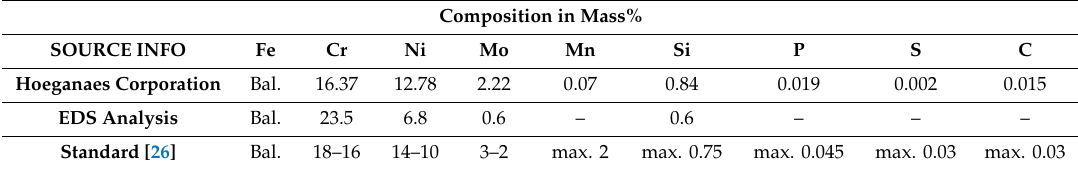
Table 1. Chemical composition of the standard 316L and the starting powder employed as feedstock.